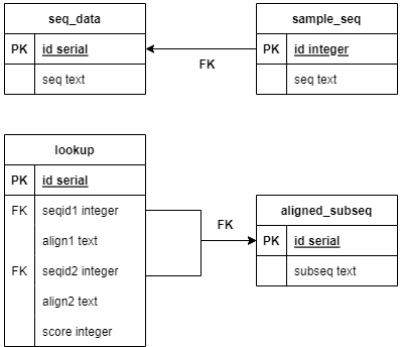
Figure 4. The tables used in the heuristic pairwise